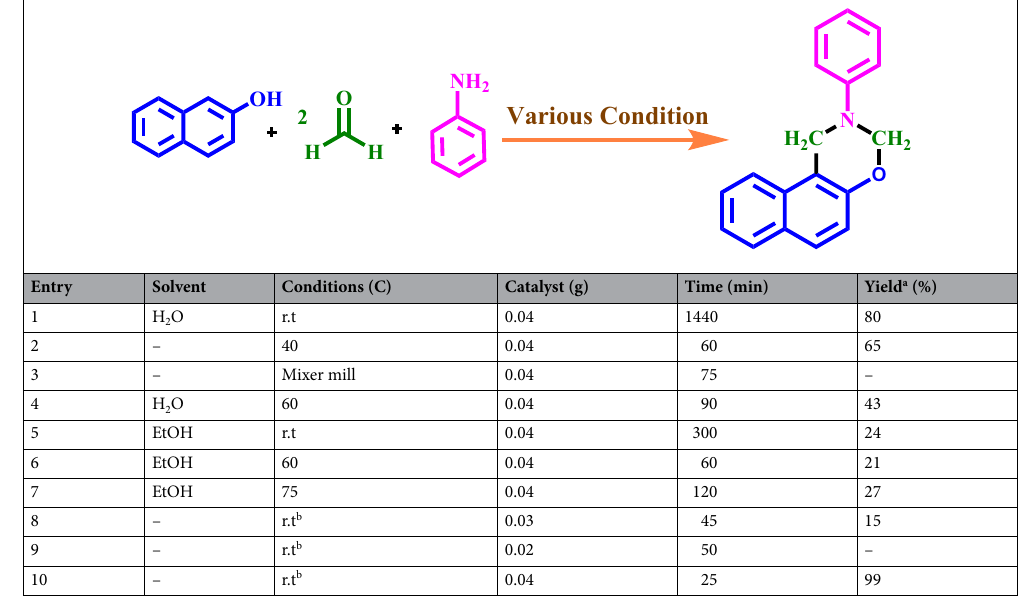
Table 1. The reaction of formaldehyde, β-naphthol and aniline in the presence of FNAOSiPAMP/Cu II under various conditions. The molar ratio of formaldehyde (2 mmol), β-naphthol (1 mmol) and aniline (1 mmol) is equal to 2:1:1. a Isolated yields. b Electrical mortar-heater.